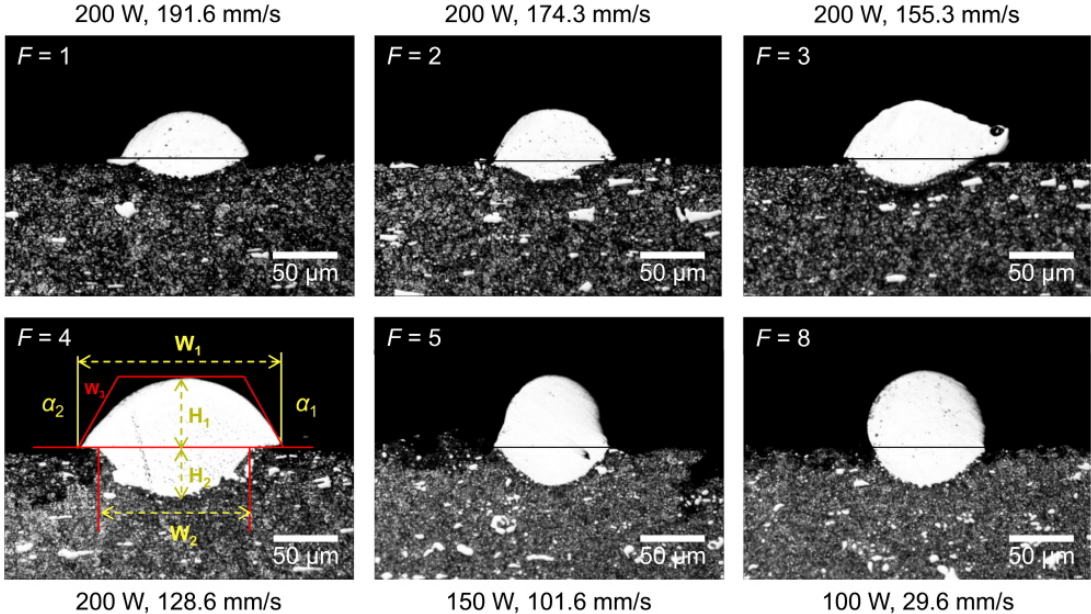
Figure 5. Various bead shapes produced during the single ‐ line formation test under six different conditions ( F = 1–5, and 8) (see Figure 3). When the laser power and scan rate were 200 W and 128.6 mm/s, respectively ( F = 4, see 2.2 to read the symbols), an optimal bead shape was achieved.